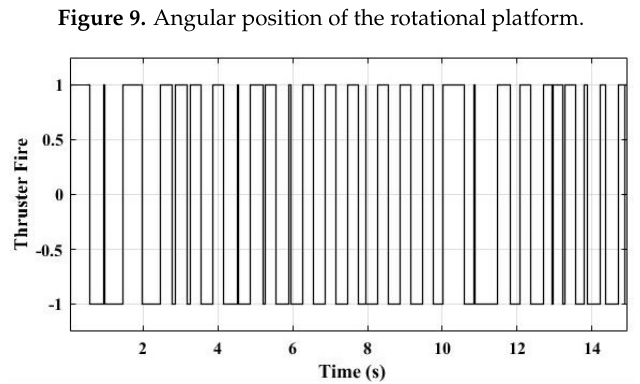
Figure 10. Thruster fire during single axis